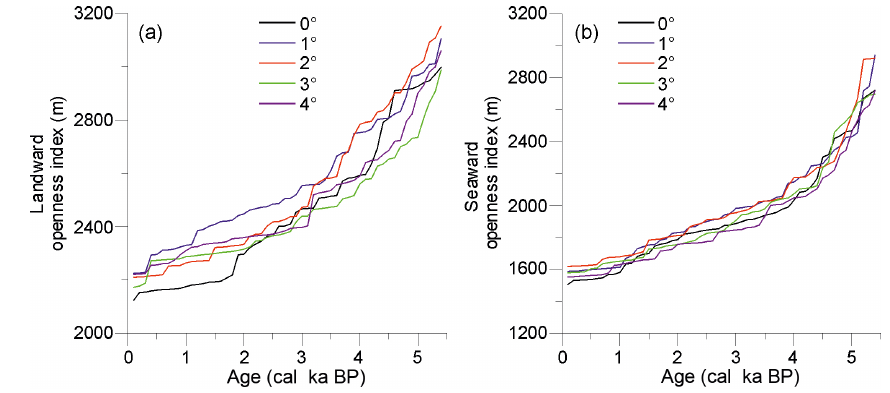
Figure 7. Calculated landward (a) and seaward (b) openness indices with 5 ◦ interval and 1–4 ◦ shift starting angles.